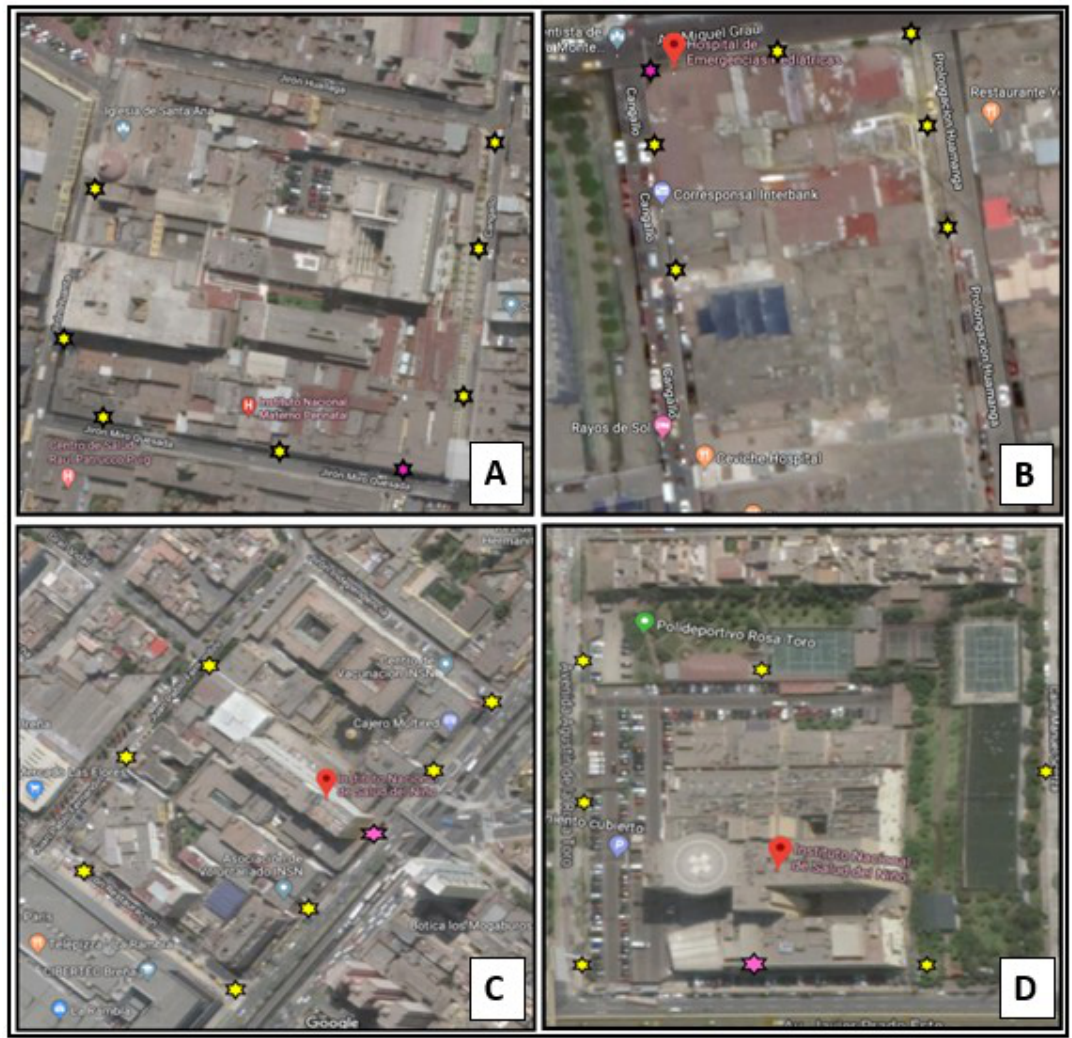
Figure 2: Exploratory Network of Measurement Points at the Four Hospitals of this Study. A) H-1: National Maternal Perinatal Institute; B) H-2: Paediatric Emergencies Hospital; C) H-3: Breña’s Children’s Hospital; D) H-4: San Borja’s Children’s Hospital Legend: yellow star: exploratory network point; blue star: point selected from the exploratory network because it is the point with the highest value. Source: Prepared by the authors based on Google image,